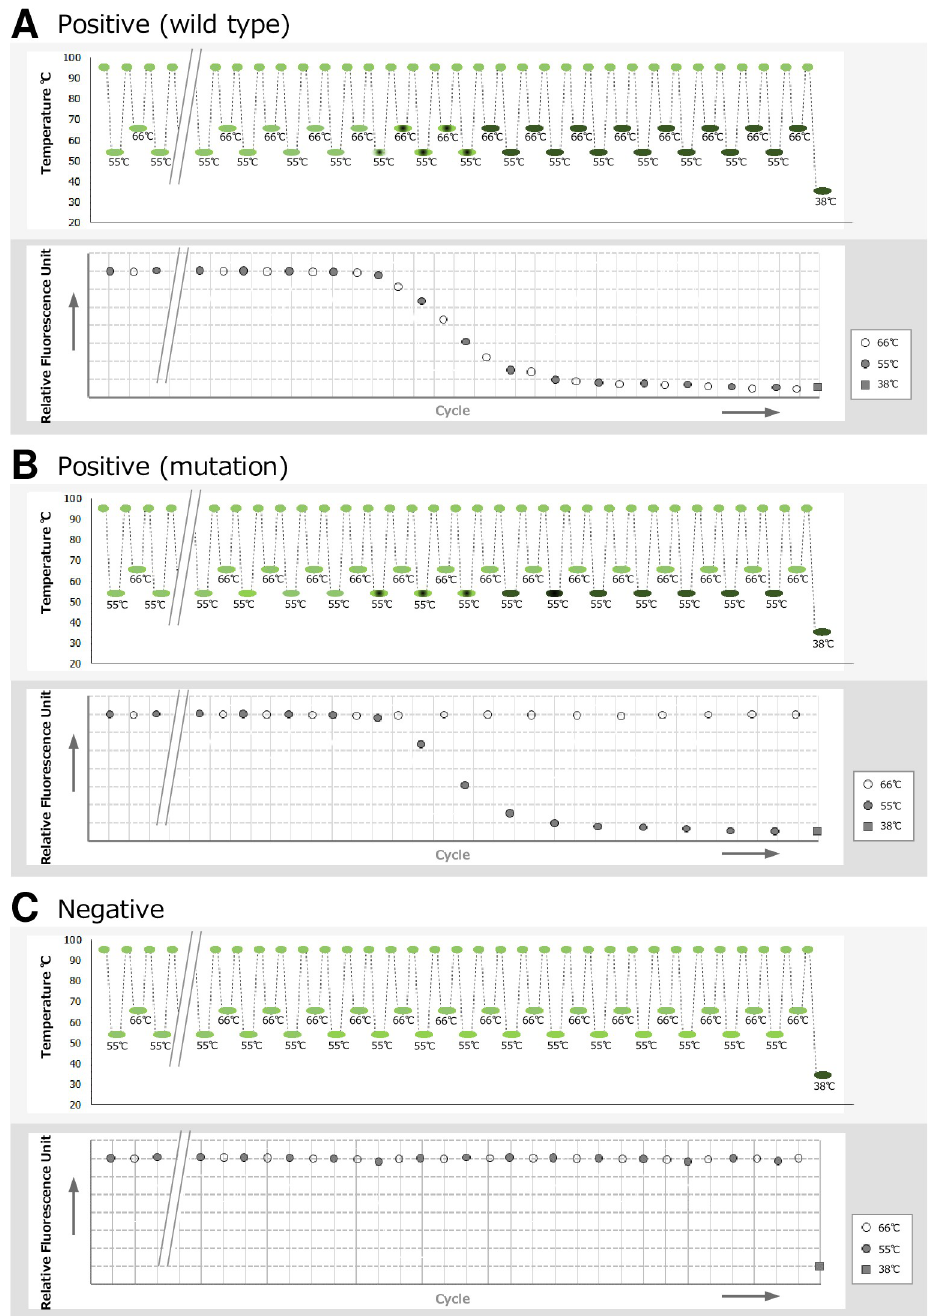
Fig 2. Schematic diagram of the amplification curve using a sample containing wild-type M . pneumoniae (A), a sample containing mutant-type M . pneumoniae (B) and a sample without M . pneumoniae (C). In the graph showing temperature cycling, green ellipsoids indicate the emission of QProbe and black ellipsoids indicate the quenching of QProbe. In the amplification curve, the fluorescence intensity of reactions is shown at 66˚C (white circle), 55˚C (black circle) and 38˚C (black